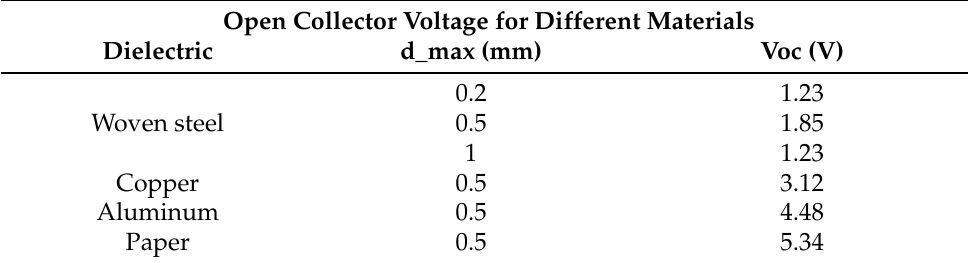
Table 8. Output voltage for different spacings and